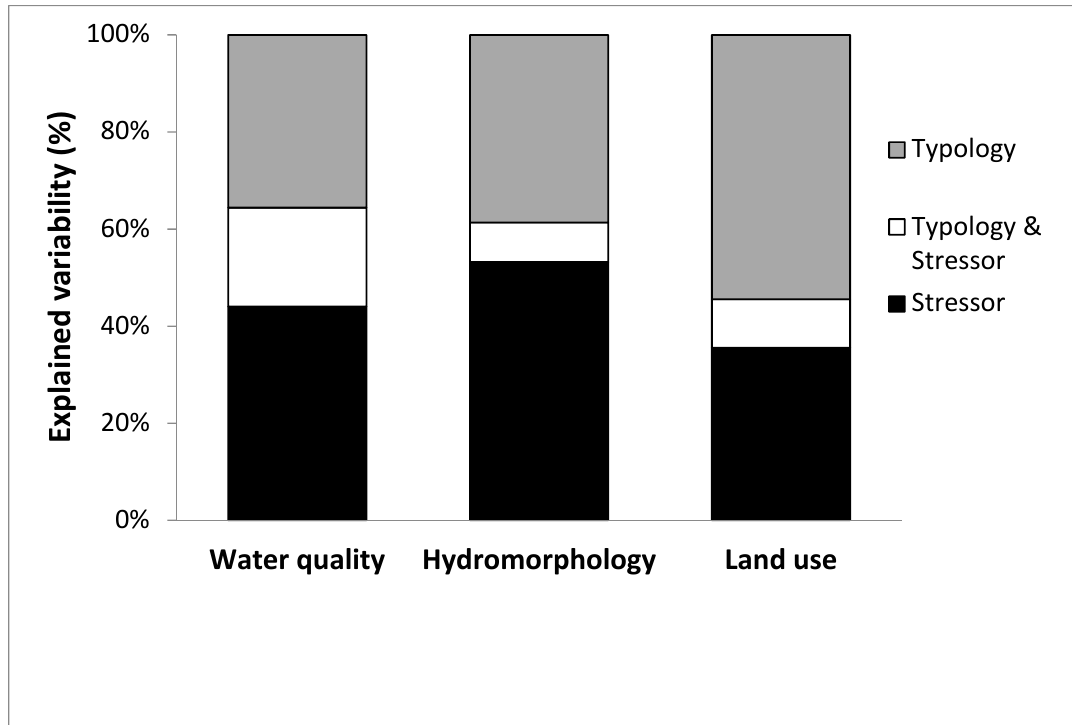
Figure 2. Unique and joint effect contribution of the typology group and each of the stressor variable groups (hydromorphology, land use, and water quality) to the explained variability of benthic invertebrate assemblages; given as percentage of joint and both unique contributions.